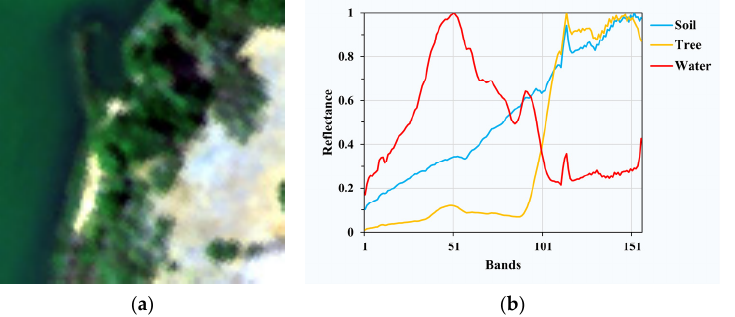
Figure 2. ( a ) Pseudo-color image of Samson; ( b ) spectral signatures of endmembers in Samson.